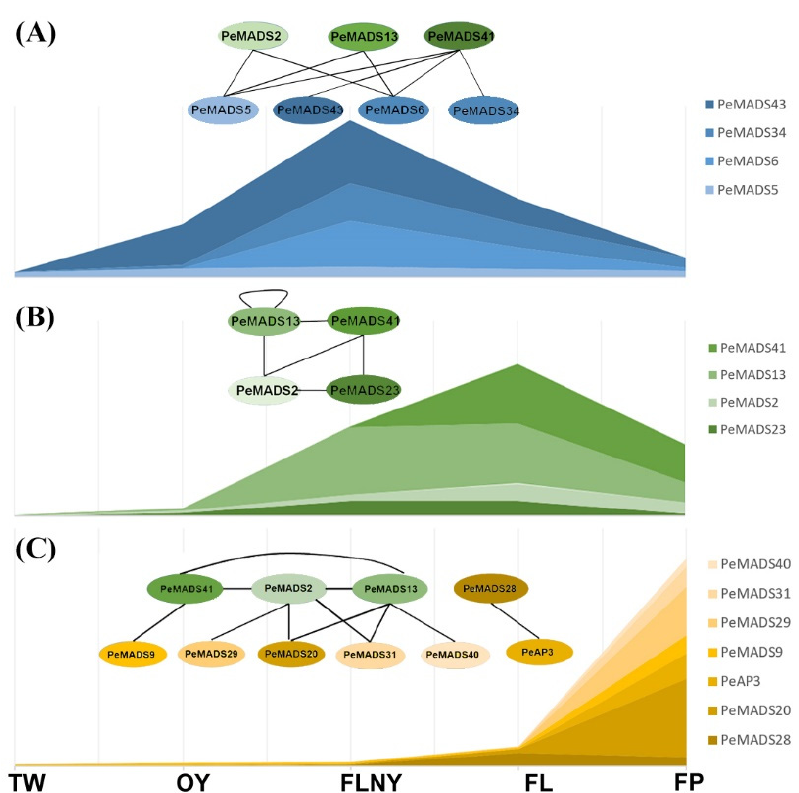
Figure 8. A hypothesis of the molecular model of PeSQUAs in flower development. The stacked graphs represent bamboo MADS-box gene expression levels. The circle represents MADS-box proteins. The solid lines between different proteins indicate the PPI validated by Y2H. The model in the FLNY stage ( A ), the model in the FL ( B ), and the model in the FP ( C ). Each oval represents a different PeMADS protein.